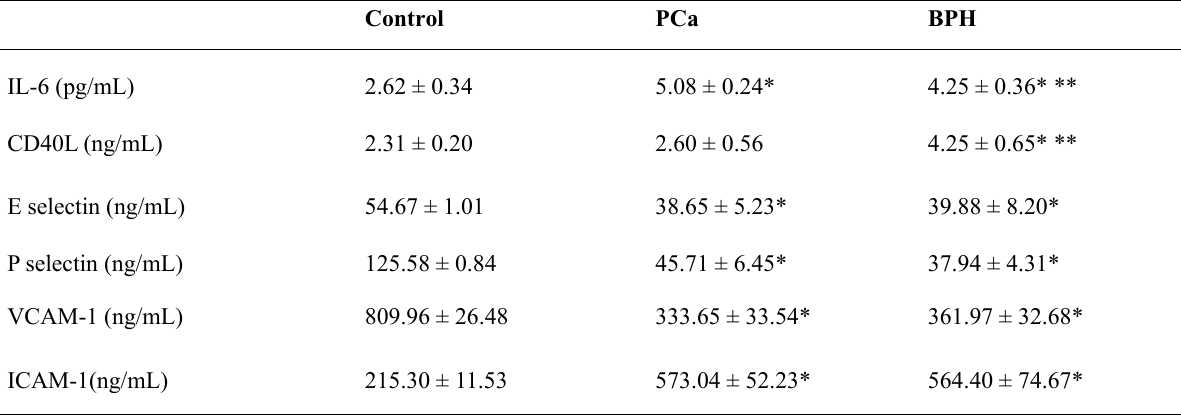
Table 1 - Parameters measured in systemic blood samples.